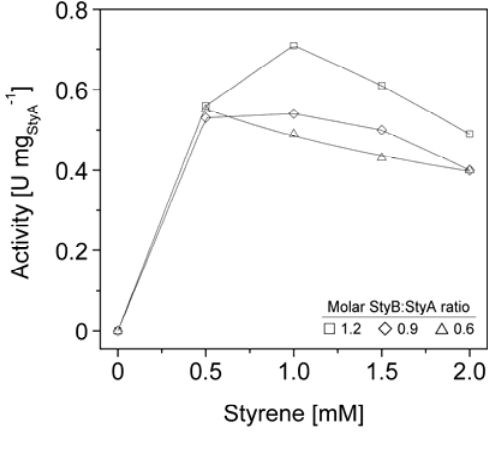
Figure 6. StyA activities immobilized from Escherichia coli JM101 (pSPZ10) cell extract on Sepabeads EC-Q1A as a function of molar StyB:StyA ratios and styrene